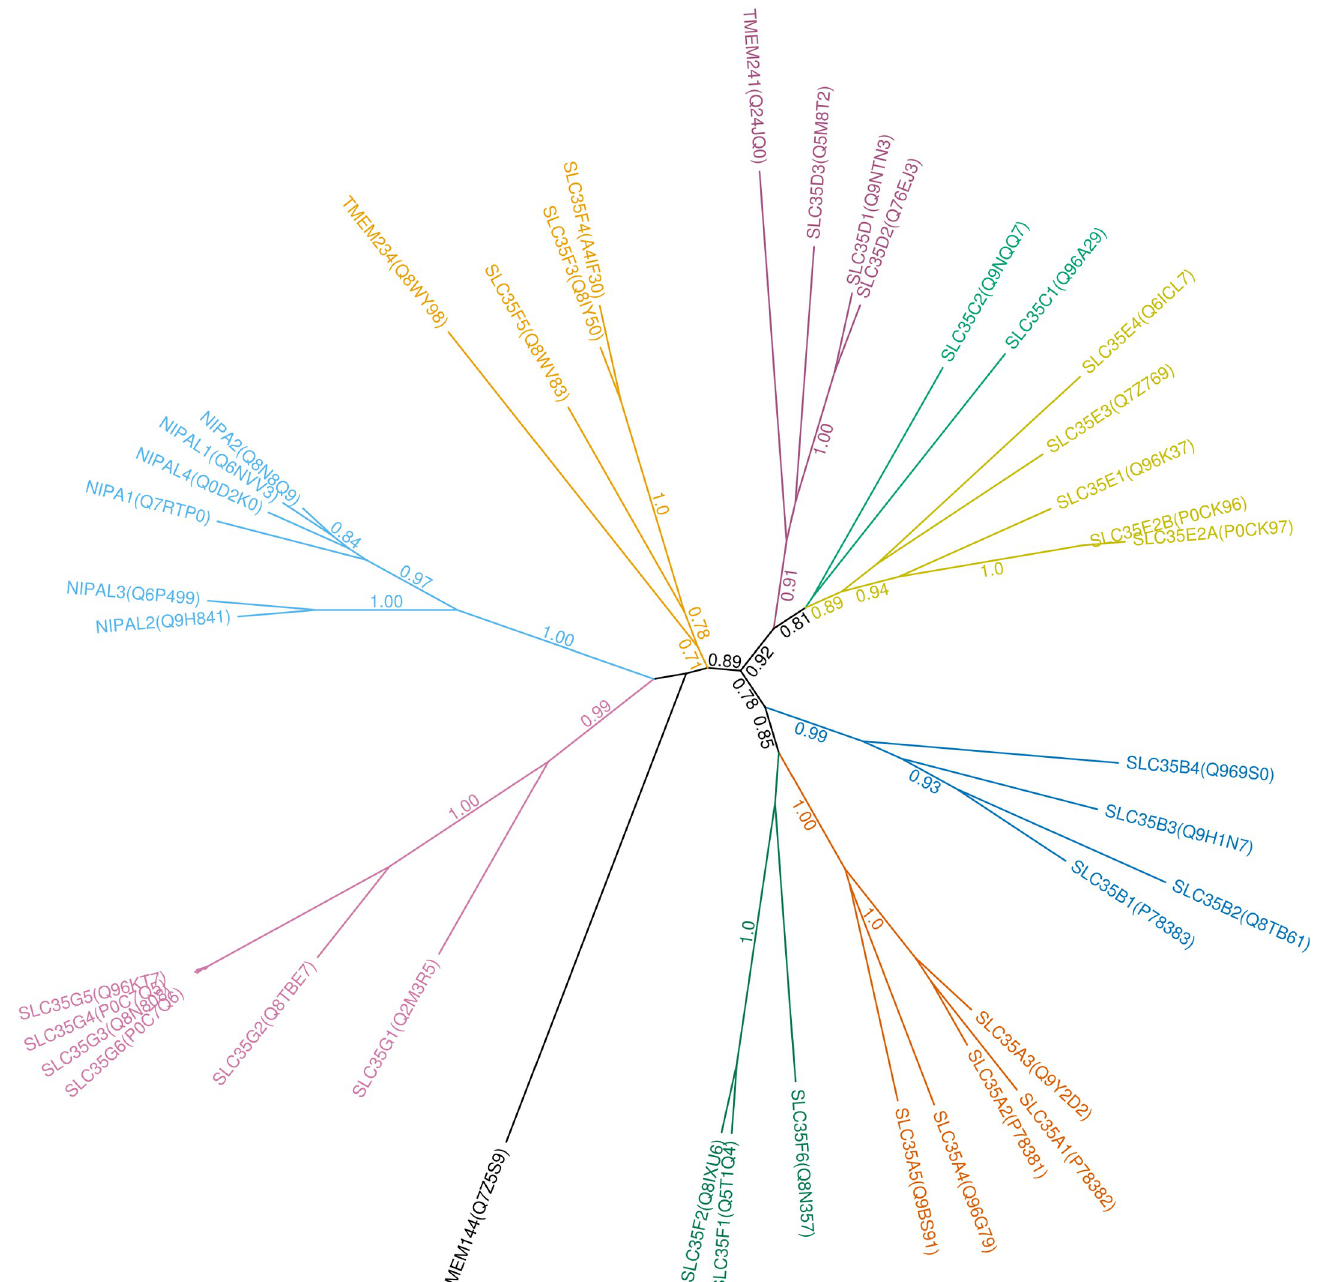
Fig 5. Phylogenetic tree of proteins with HMM fingerprints overlapping with the SLC35 family. Branch support values � 0.7 are shown. The different subfamilies are colored in various colors.